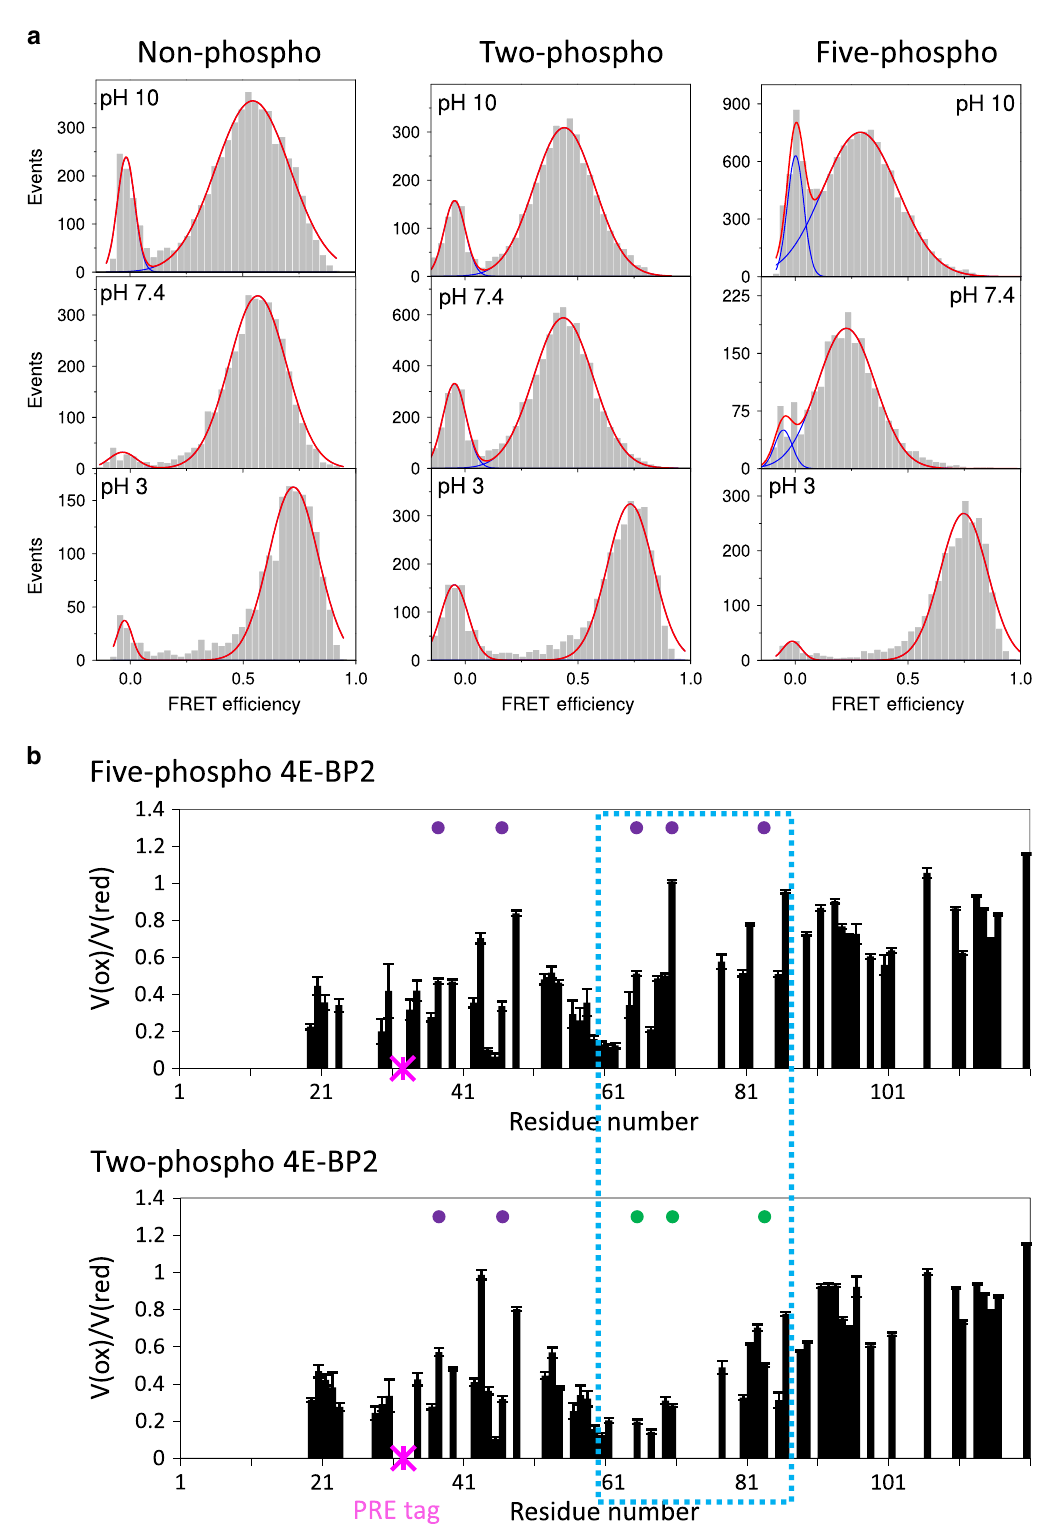
Fig. 5 C-IDR phosphorylation and pH affect interactions between folded domain and C-IDR. a smFRET data for acid denaturation of np-4E-BP2, 2p-4E- BP2, and 5p-4E-BP2, respectively, with dyes at residues 32 and 91. The FRET ef fi ciency is inversely proportional to the sixth power to the separation between the dyes. The red dashed lines are Gaussian fi ts to the data, whose maxima indicate the locations of the peak FRET ef fi ciency for the non-zero Gaussian. The average FRET values have an error of ±0.01. b NMR paramagnetic resonance enhancement (PRE) data for 2p-4E-BP2 and 5p-4E-BP2 proteins with nitroxide spin labels at residue 32. The attenuation of NMR peak intensities ( V (ox)/ V (red)) is proportional to the distance between the nitroxide label and backbone amide groups. The error bars are based on the propagation of the fi t heights of the peak volumes. Purple circles indicate phosphorylated residues and green circles are sites of alanine mutations. Source data are provided as a Source Data fi